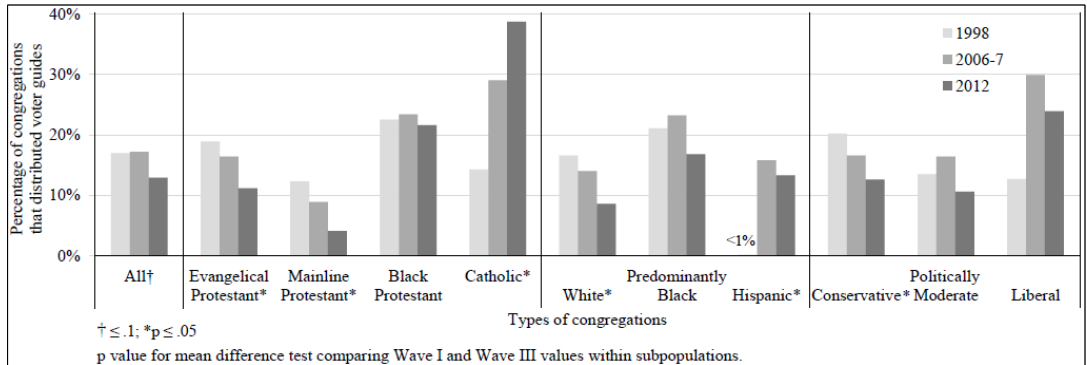
Figure 5. The percentage of congregations by subpopulation that distributed voter guides by wave.